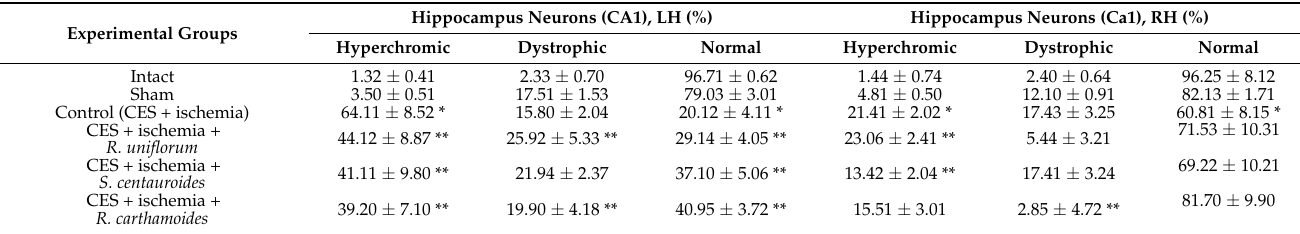
Table 6. The effects of R. uniflorum and S. centauroides extracts on the contents of different neurons in the dorsal hippocampus (CA1) in rats subjected to chronic emotional stress (CES) and ischemia. Experimental